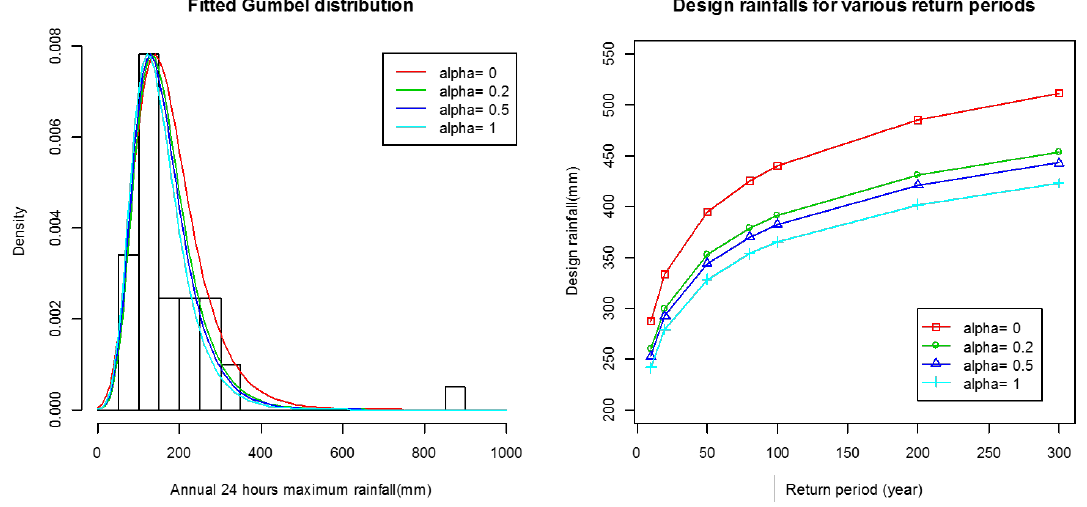
Figure 6. Gumbel distribution fitted to the 24-h annual maxima at Gangneung (Station 105) and design rainfall depending on the return periods.